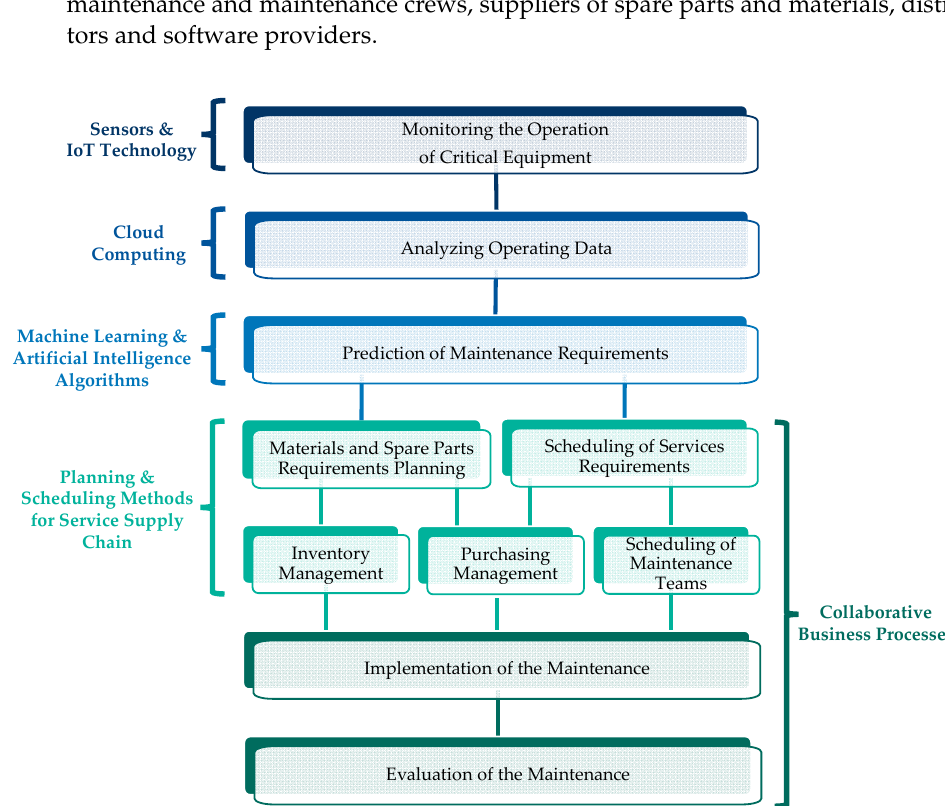
Figure 2. The System’s Operational Framework: Main Functionality and the Embedded Technologies and Methods.